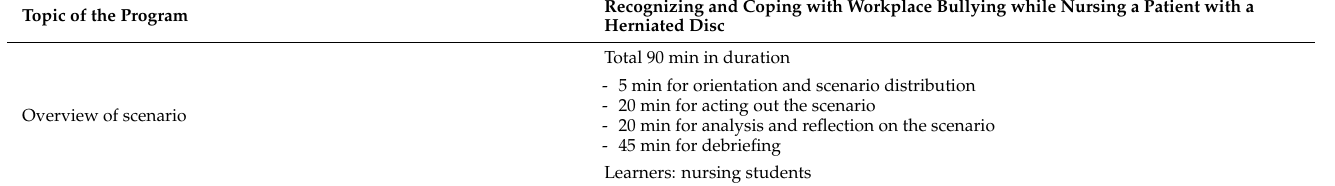
Table 1. Demonstration scenarios for the